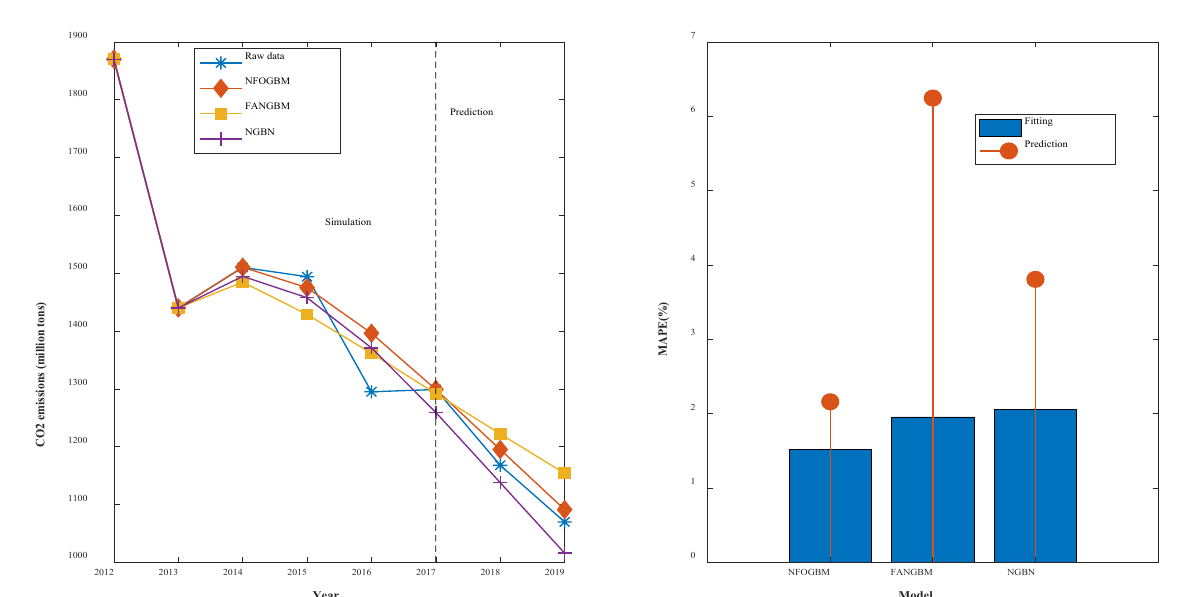
Figure 6. Fitting curves and error plots of the SPFM results. (5) The modeling results for NMMD are shown in Table 6, and the fitting and error plots are shown in Figure 7. The MRPESs (%) of the NFOGBM, FANGBM, and NGBM are 2.191, 1.998, and 2.52, respectively; the MRFPEs (%) are 1.938, 5.83, and 8.06, respectively, and the CMRPEs (%) are 2.128, 2.956, and 3.905. Similar to the previous example, although the FANGBM yields the lowest simulation error, while the NFOGBM produces the lowest prediction error and combined error, and the corresponding modeling curve fits the orig- inal data the best; therefore, among these three models, the NFOGBM provides the best modeling